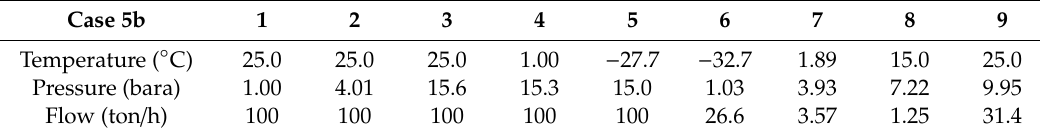
Table A11. Mass balance for Case 5b, stream numbering from Figure 2.